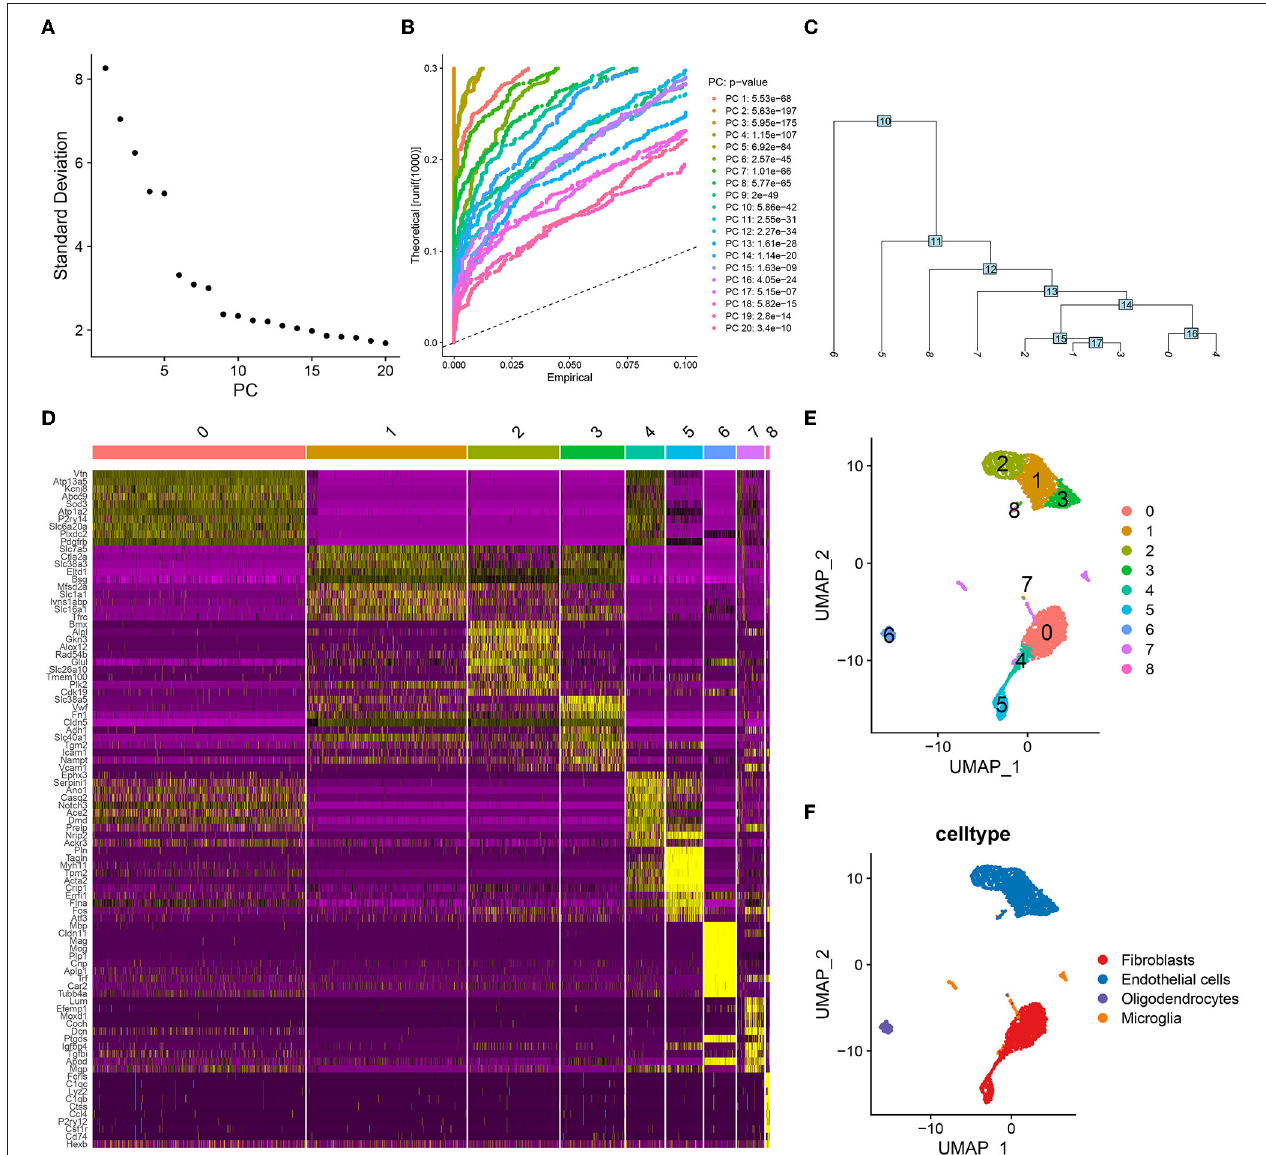
FIGURE 1 | Cell clustering and annotation processes in single-cell analysis. (A) The top twenty principal components (PCs) were ranked according to the extent of the explanatory difference between them. According to the calculation, several PCs between 10 and 20 may cover all features of ICI. Here, 15 PCs are selected for the following round of investigation. (B) The top 20 PCs were found to be significantly enriched for features with low P-values. (C) A tree was constructed during the cell-clustering phase and nine distinct cell clusters were obtained. (D) The heat map shows the significant differences in the expression of marker genes in these nine cell clusters. (E) UMAP visualized the distribution of nine cell clusters. (F) These four cell clusters were annotated as fibroblasts, endothelial cells, oligodendrocytes and microglia,